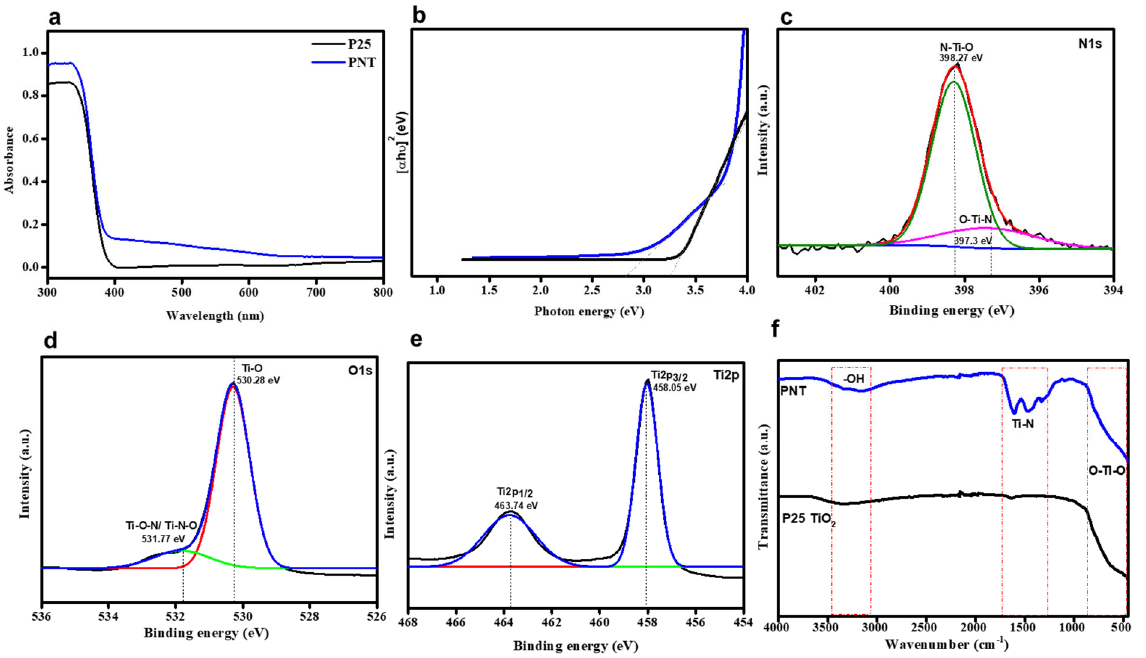
Figure 1. ( a ) UV-VIS diffuse reflectance spectra of P25 and PNT samples. ( b ) Band gap value of P25 and PNT samples. ( c ) XPS spectra of N1s, ( d ) XPS spectra of O1s, ( e ) XPS spectra of Ti2p, ( f ) FT-IR spectra of P25 TiO 2 and PNT.